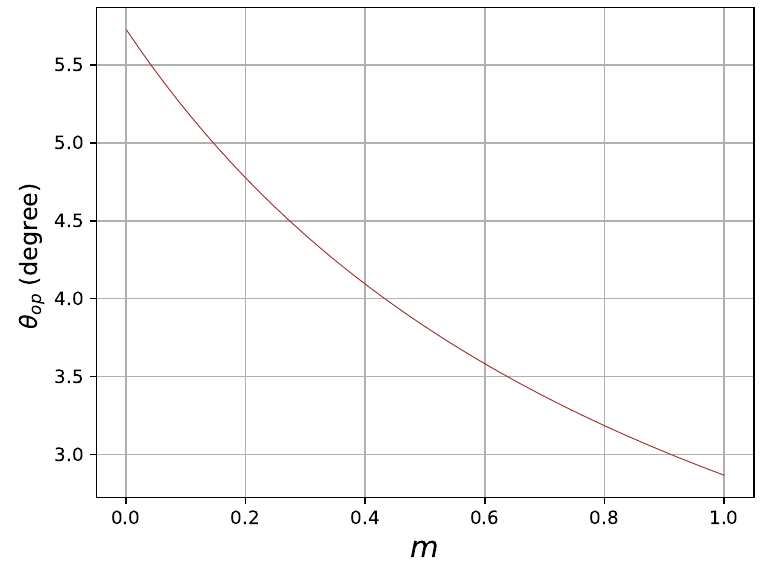
Figure 2. Opening angle θ op as a function of m at r = 100 (as r >> d